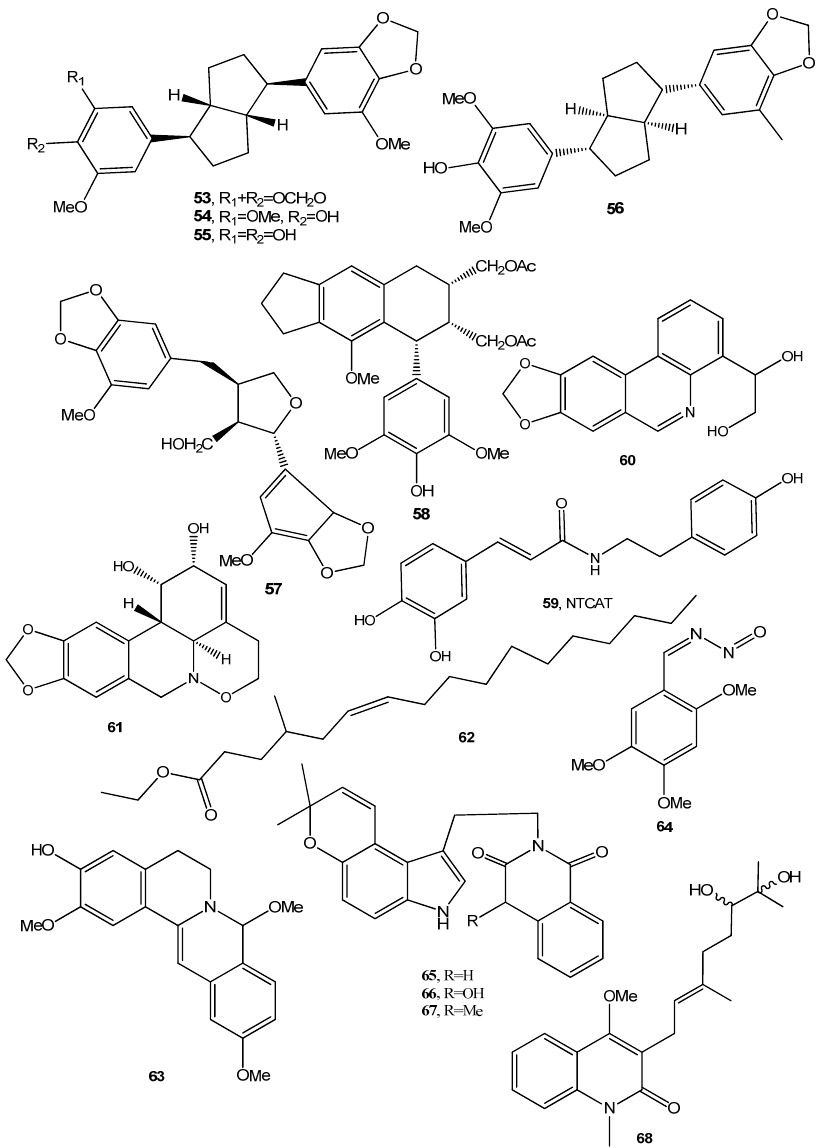
Figure 5. The structures of compounds 53 – 68 .